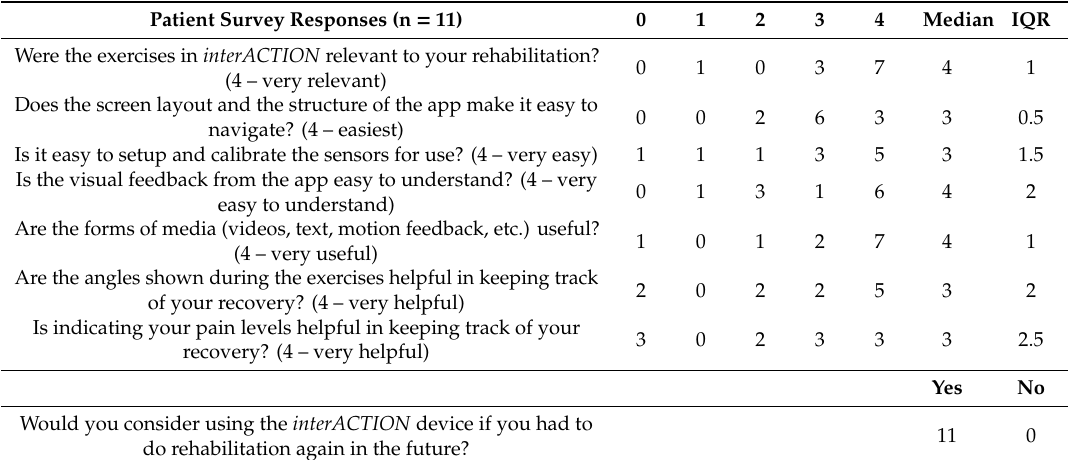
Table 5. Patient survey responses (n = 11).